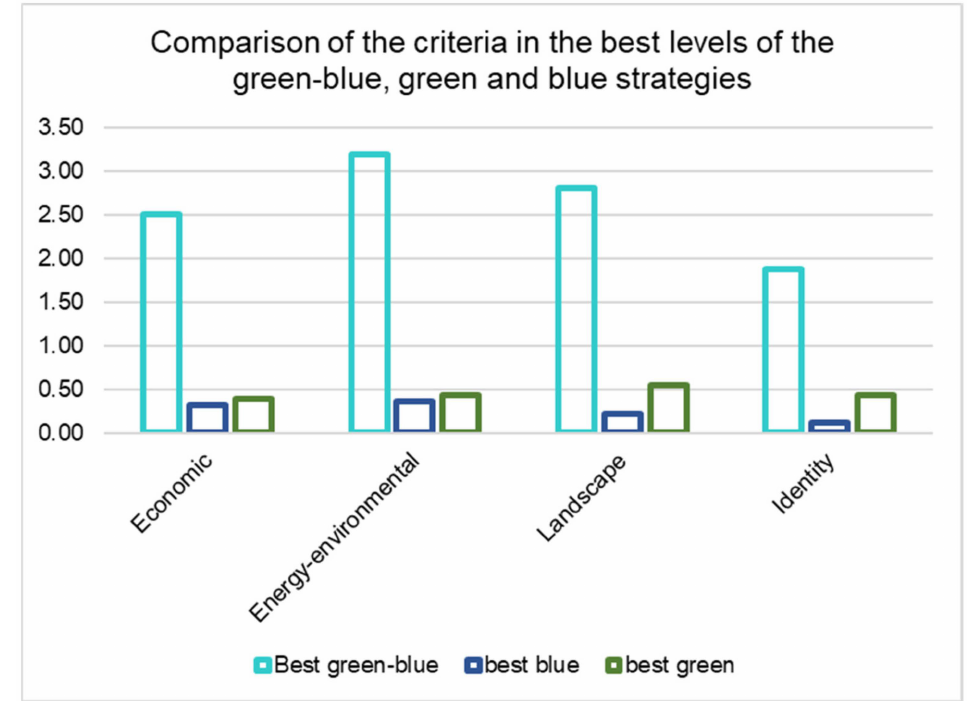
Figure 10. Comparison of criteria for the best level of strategies